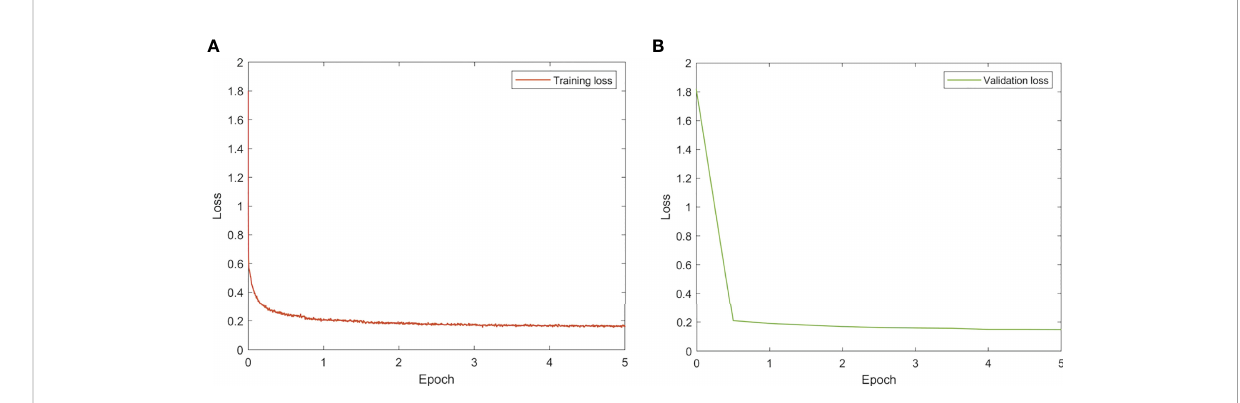
FIGURE 2 Learning curves of the deep learning model. (A) Training loss. (B) Validation loss.